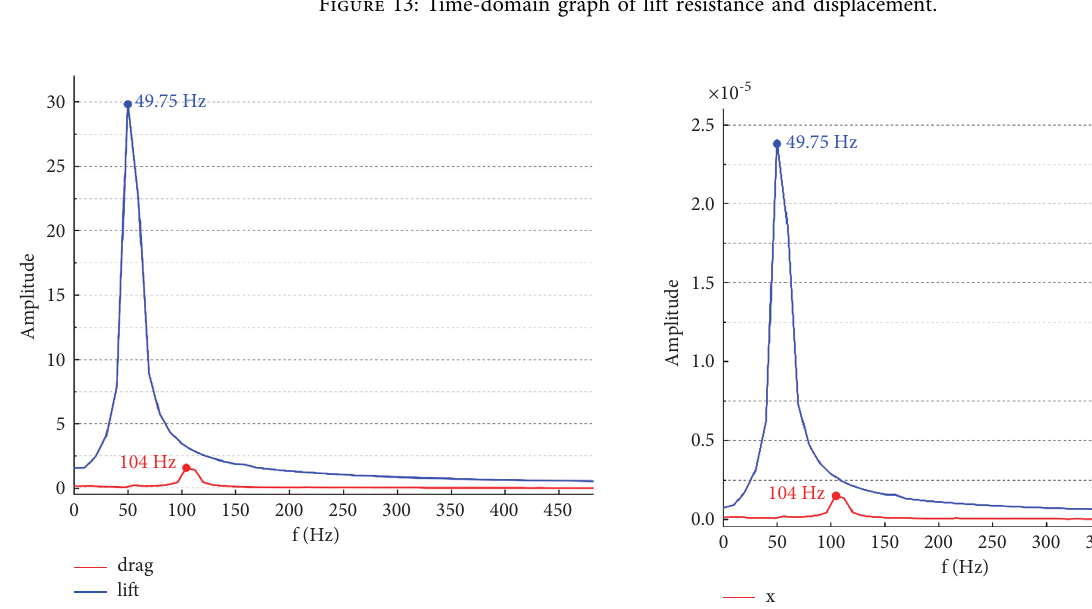
Figure 14: Frequency diagram of lift and drag.